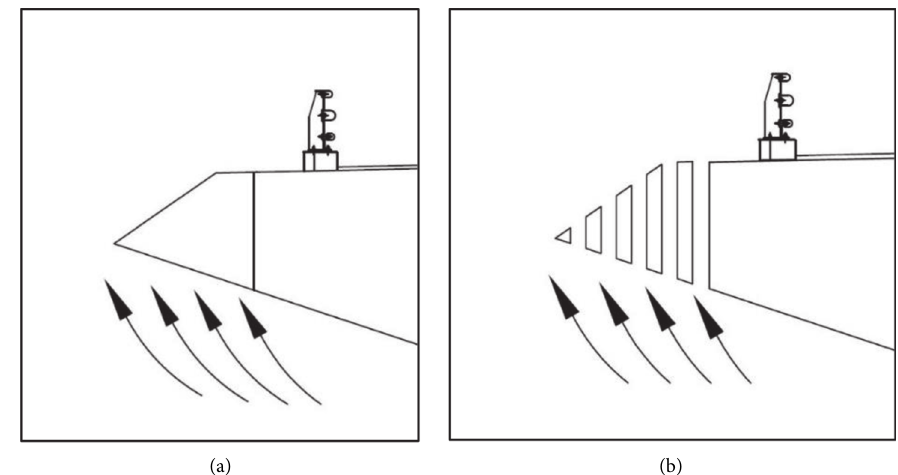
m : (a) laminar flow; (b) turbulent flow.